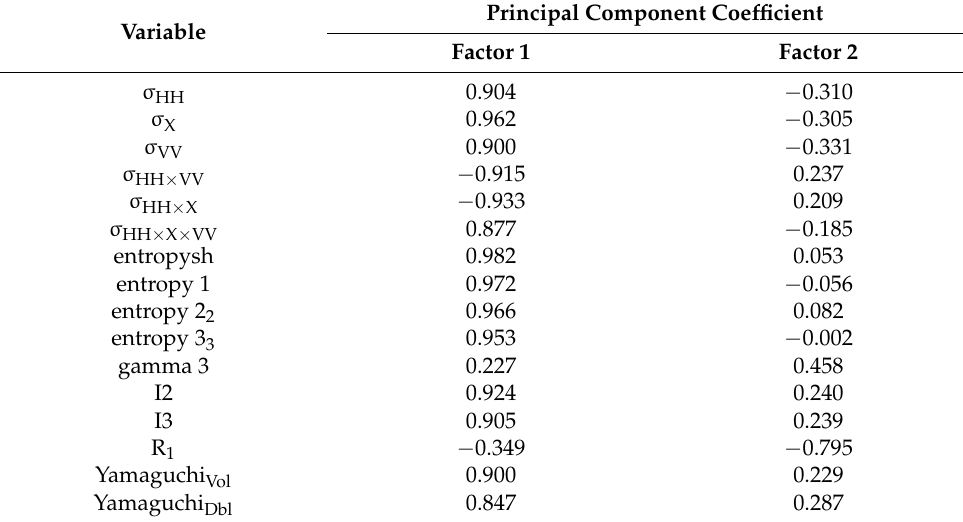
Table 10. Principal component coefficient.